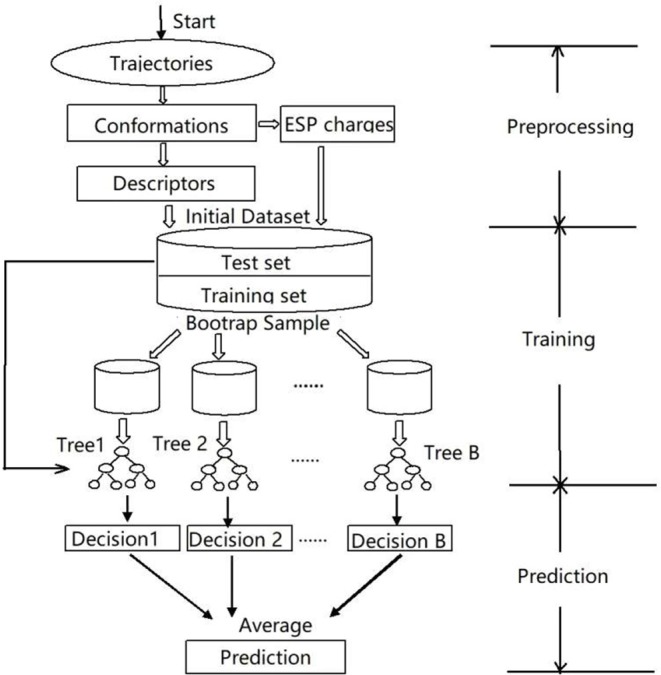
The work flow of construction data set and prediction process of the RFR model.